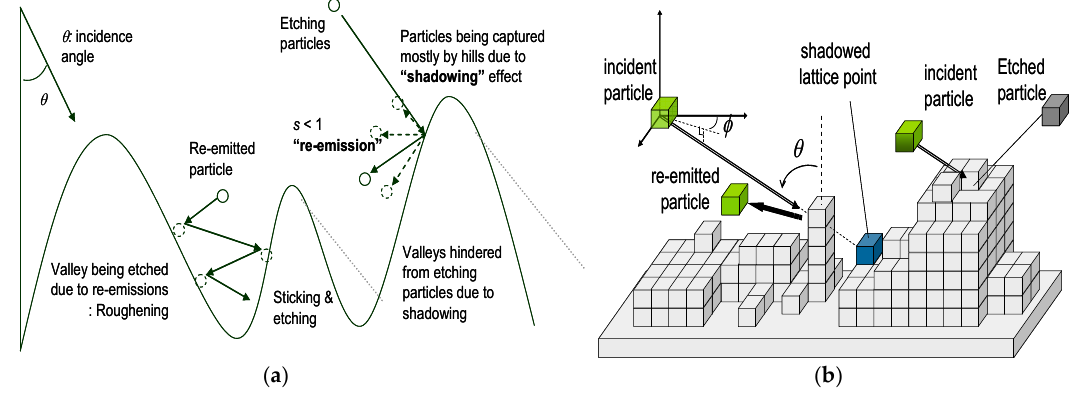
Figure 1. Shadowing and re ‐ emission effects during etching ( a ) and Monte Carlo simulations of oblique angle etching (OAE) ( b ) are illustrated.